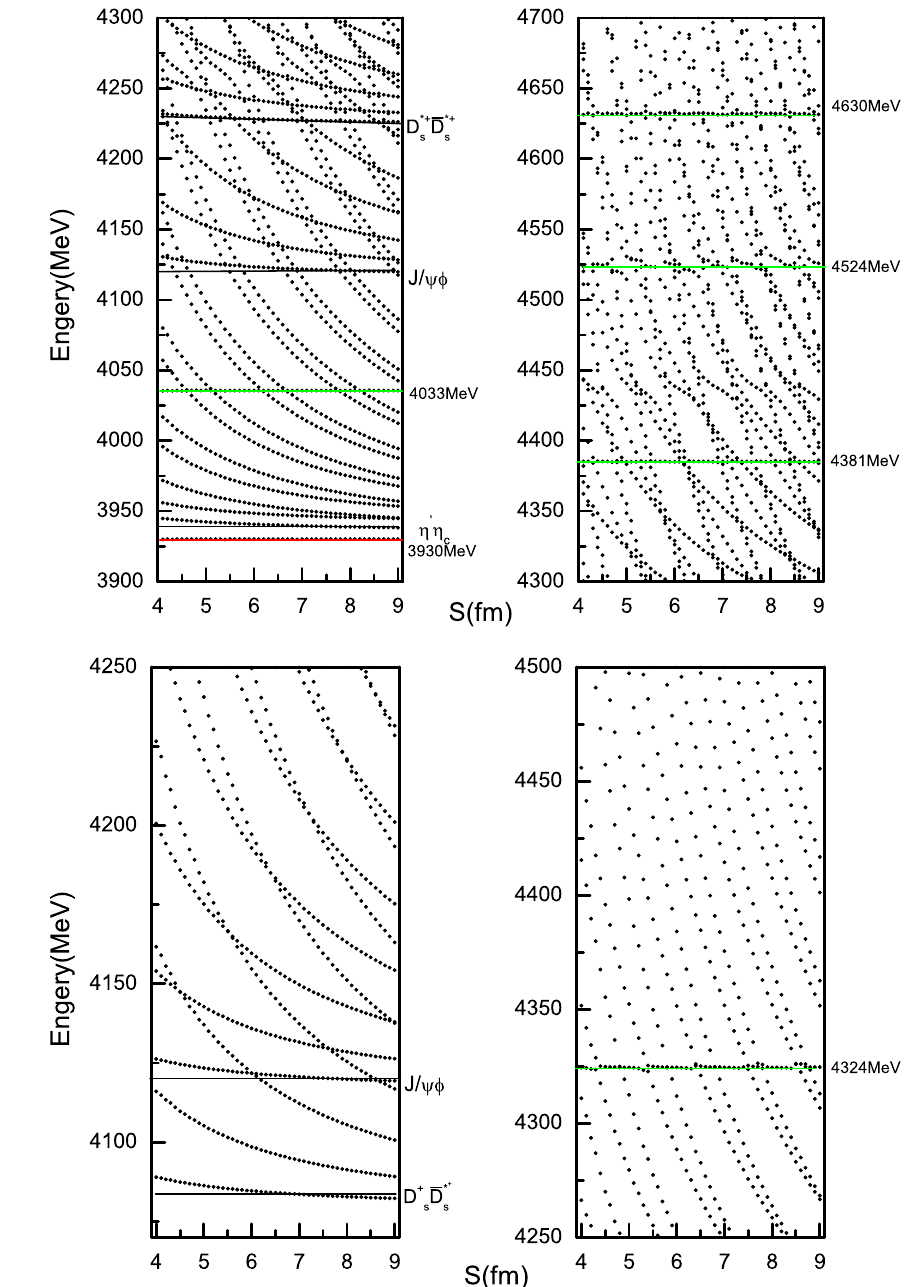
Fig. 3 The stabilization plots of the energies of the c ¯ cs ¯ s with J PC = 01 ++ in